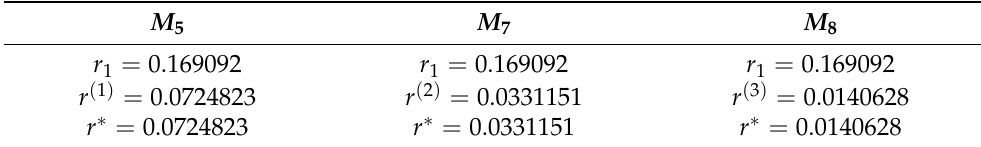
Table 2. Numerical results for example 2.